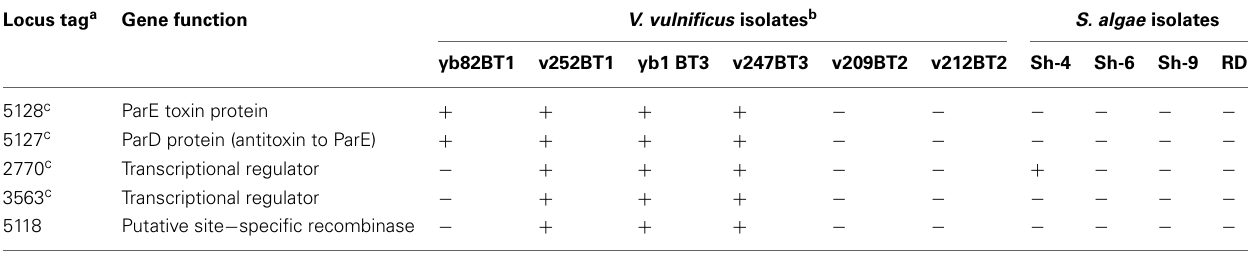
Table 3 | PCR amplification results of five “unique” biotype 3 genes in S. algae and V. vulnificus isolates. Locus tag a Gene